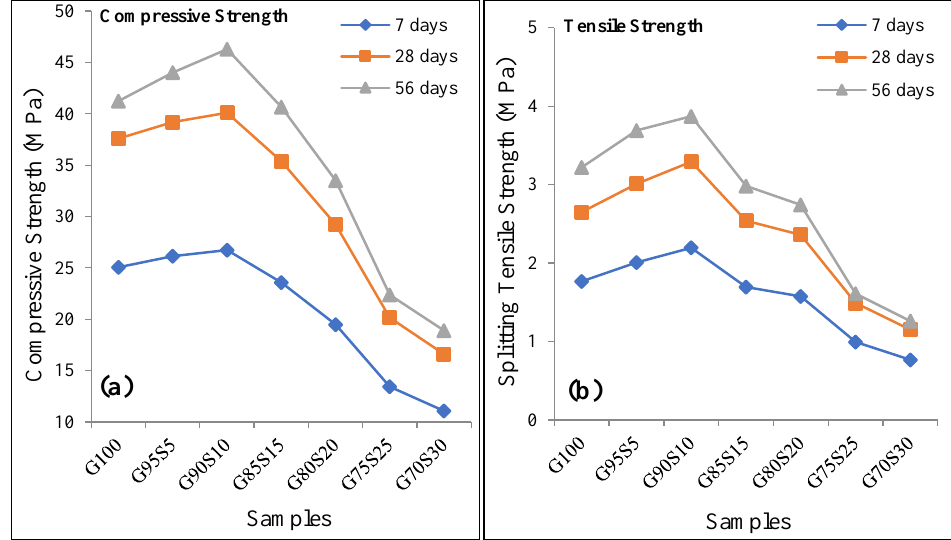
Figure 1. Test results for ( a ) compressive strength ( b ) splitting tensile strength.